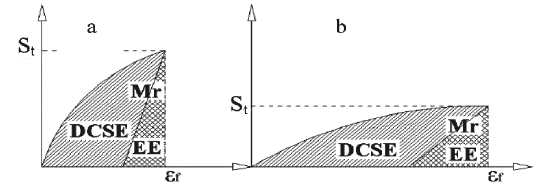
Table 5. Normalized energy based parameters for different specimens and testing conditions Testing